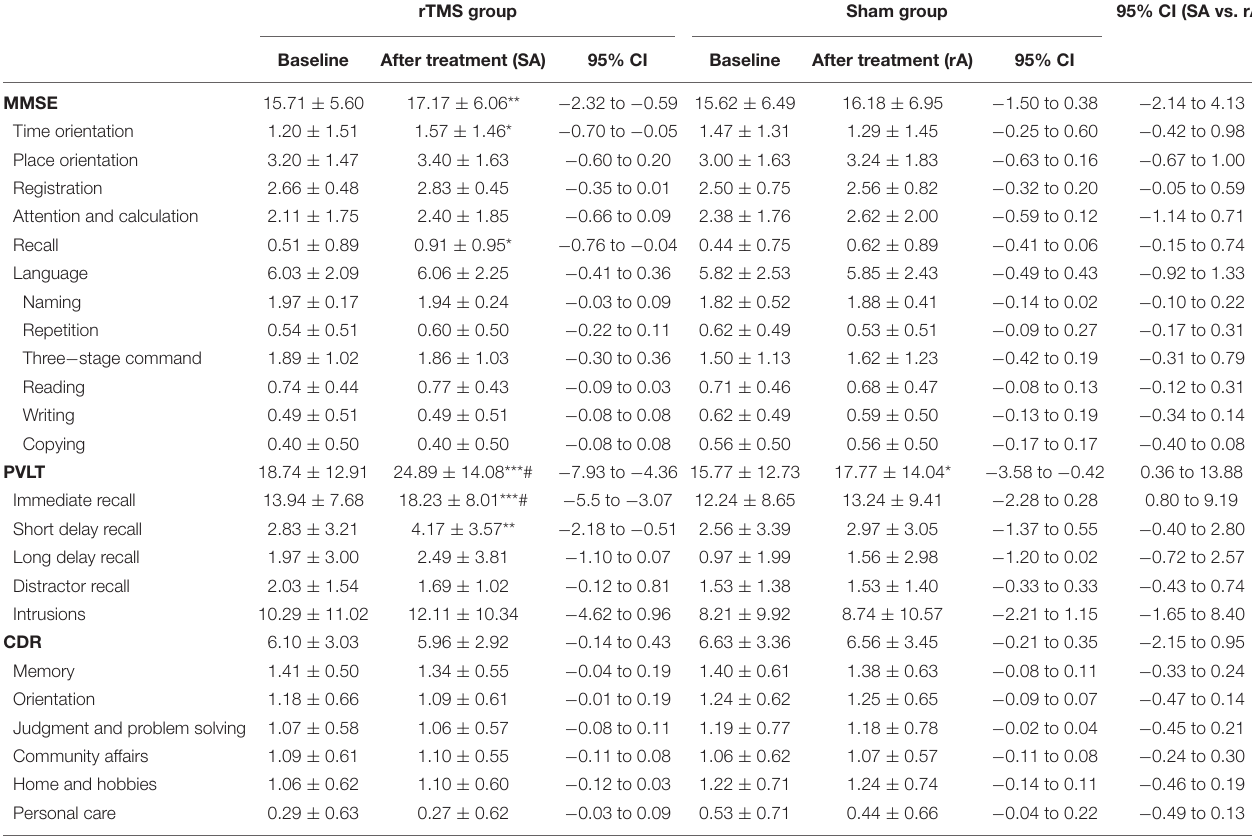
TABLE 2 | Scores (means ± SD) of MMSE, CDR, and PVLT at baseline and after rTMS/sham treatment in the rTMS group ( n = 35) and sham group ( n =